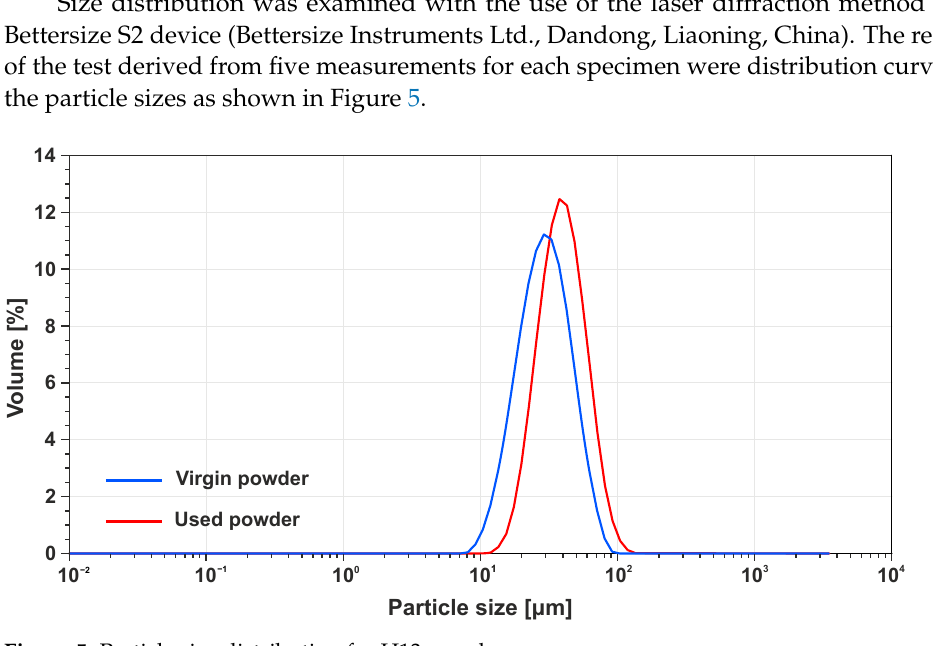
Figure 5. Particle size distribution for H13 powder.